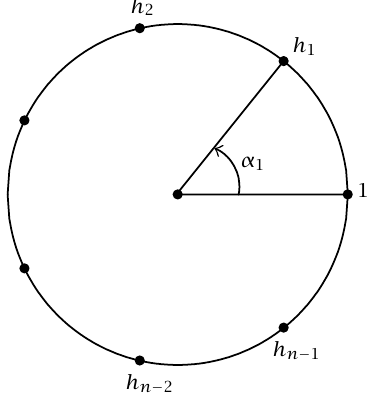
Figure 2.1 . Representation of the polar n -complex bases 1 ,h 1 ,...,h n − 1 by points on a circle at the angles α k = 2 πk/n